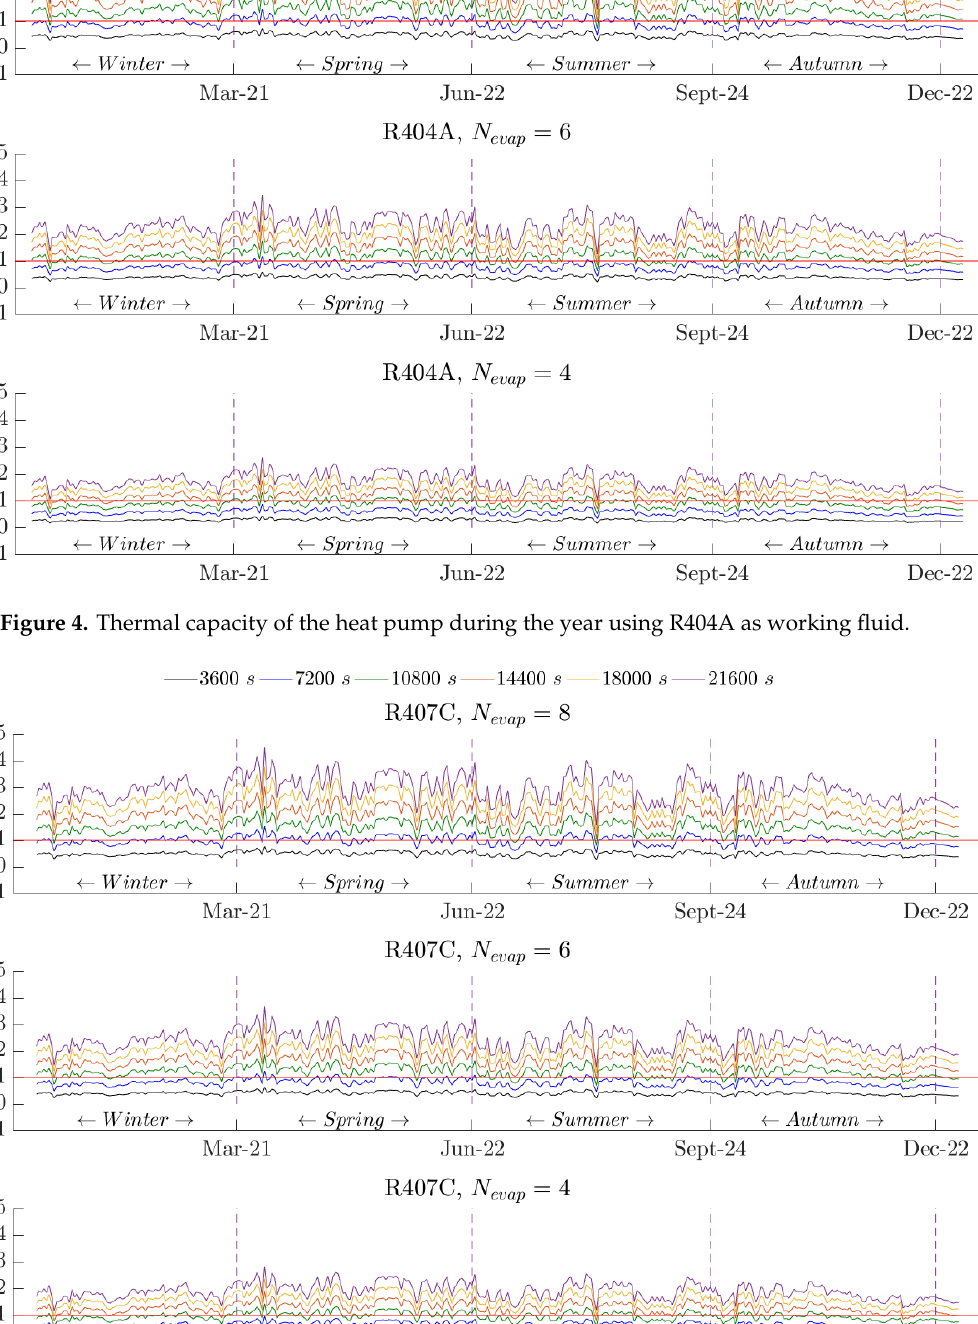
Figure 5. Thermal capacity of the heat pump during the year using R407C as working fluid.